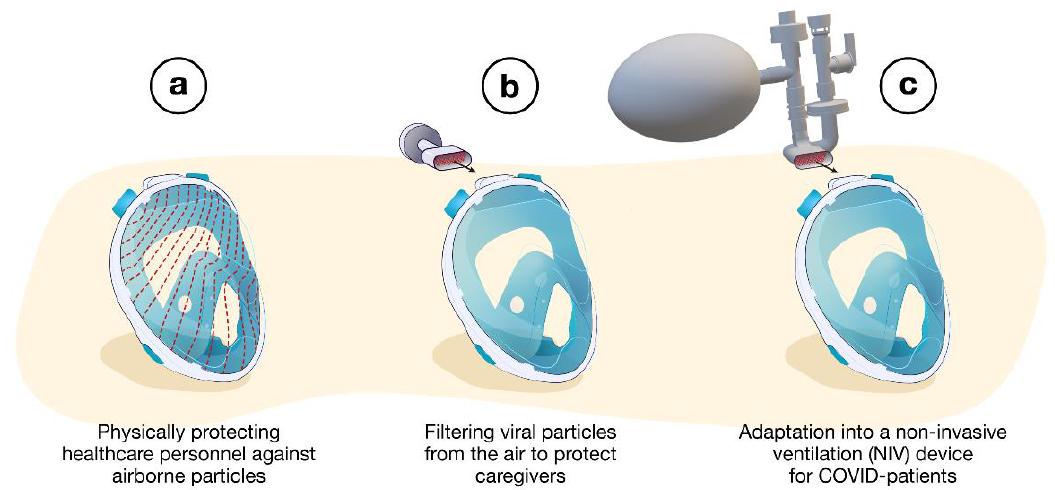
Figure 1. Different strategies used to redesign snorkeling masks for medical use during the COVID-19 pandemic: ( a ) splash-proof face shields, ( b ) respirator masks, ( c ) non-invasive ventilation devices.